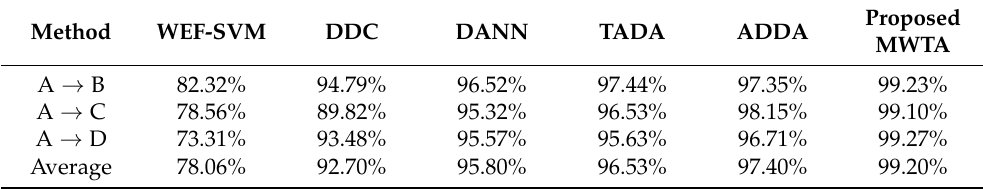
Table 3. The fault identification results of the proposed method and typical methods.